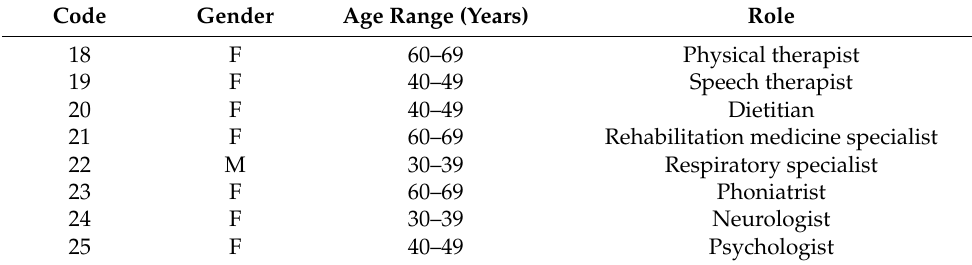
Table 4. Characteristics of HPs (n =